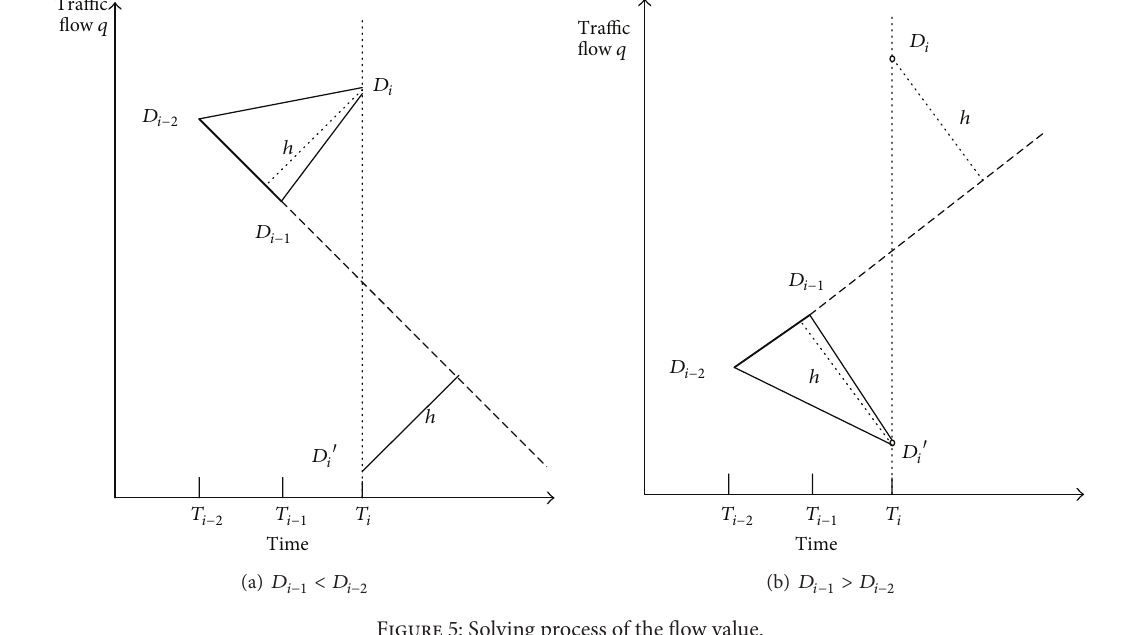
Figure 5: Solving process of the flow value.